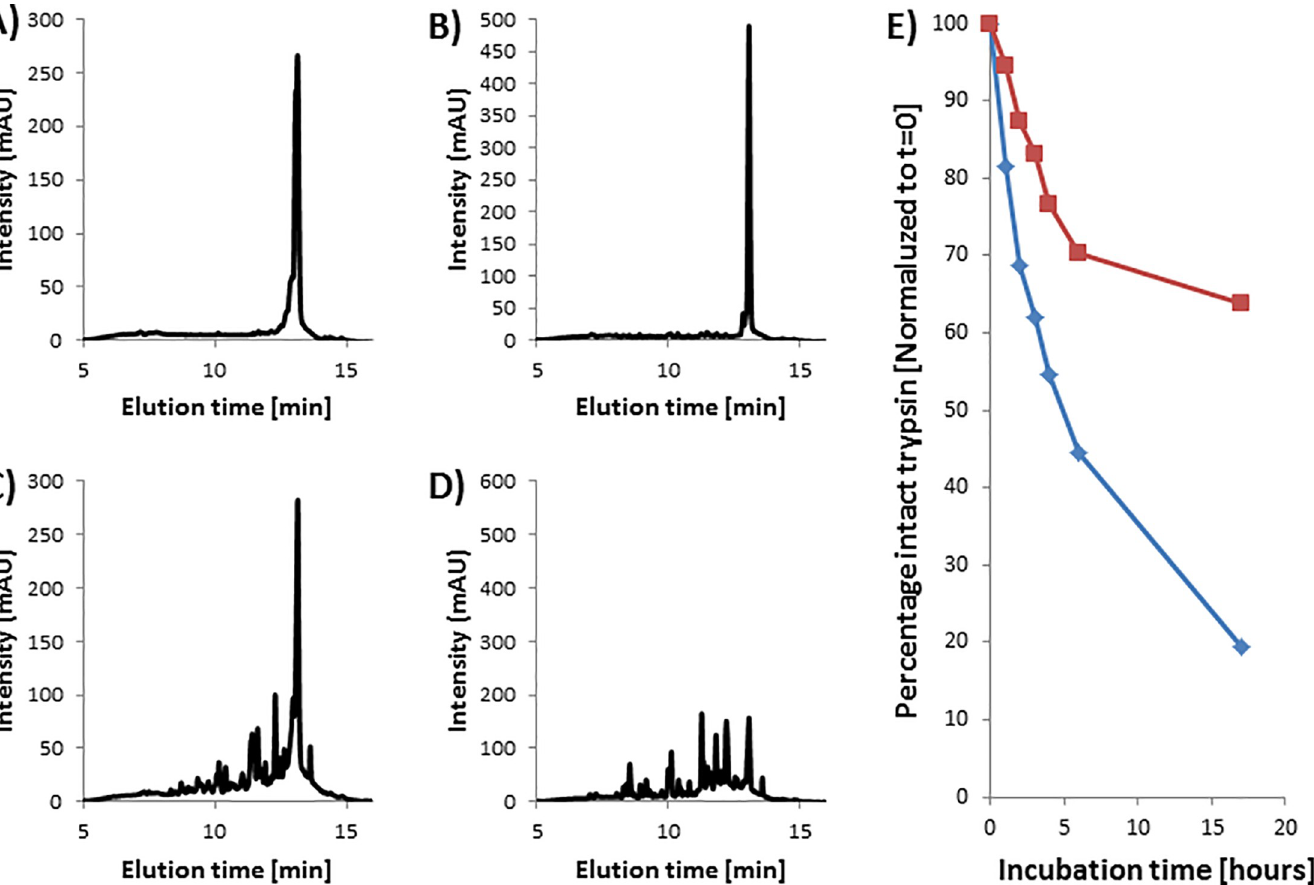
Fig 4. Autodigestion of trypsin. (A)-(D) HPLC chromatograms of trypsin during autodigestion at 37˚C. Enhanced trypsin is shown after 0 (A) and 17 (C) hours. Crude Sigma IX-S trypsin is shown after 0 (B) and 17 (D) hours. (E) Stability of crude (blue diamonds) and enhanced (red squares) Sigma-IX-S trypsin towards